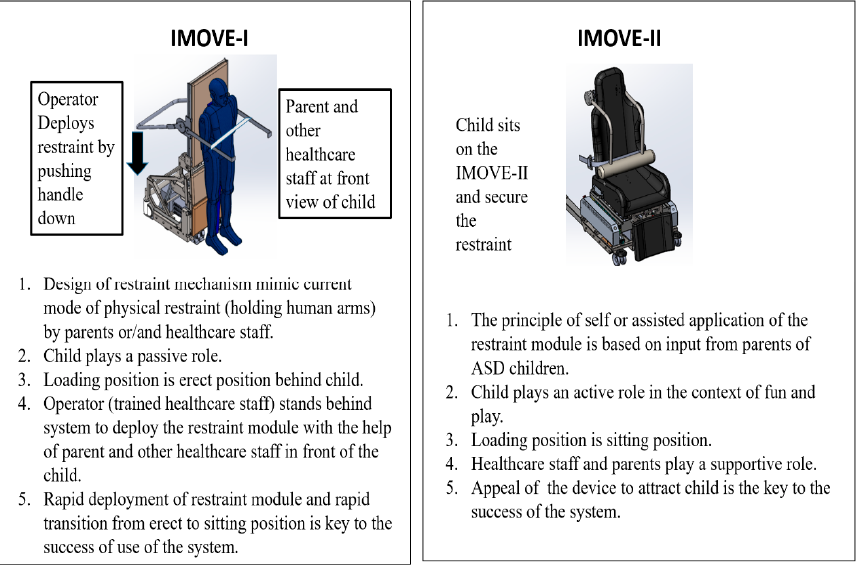
Figure 1. Methods of loading and engaging child in IMOVE systems.